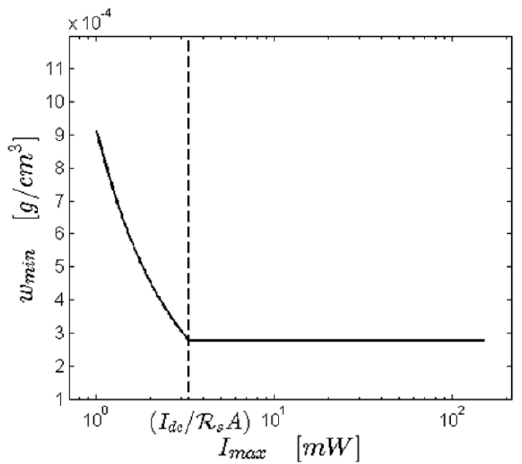
Figure 2. Minimum measurable particle concentration as a function of the maximum available laser power for the case of lysozyme and instrument sensitivity as detailed in Section 4.3. The vertical dashed line marks the boundary between the two regimes as detailed in the text.